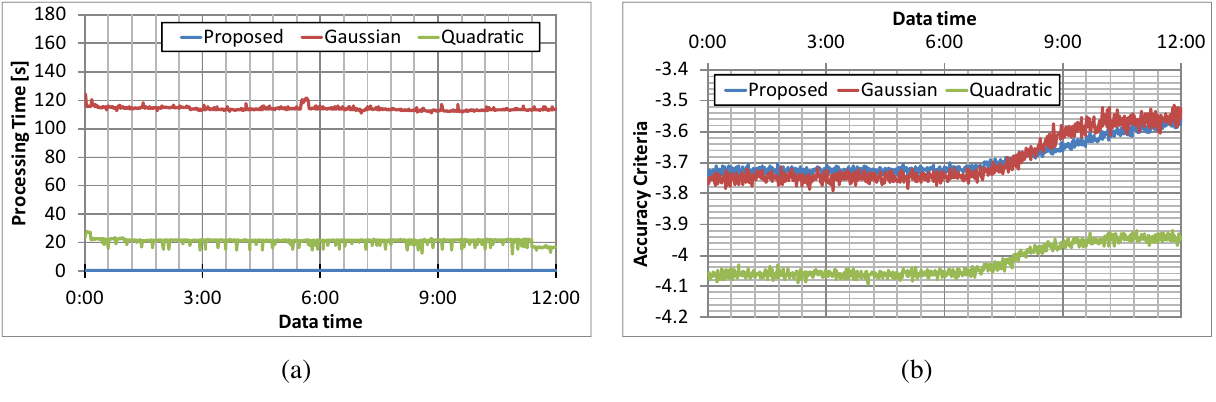
Figure 6. Results of evaluations. ( a ) Processing-time comparison; ( b ) accuracy